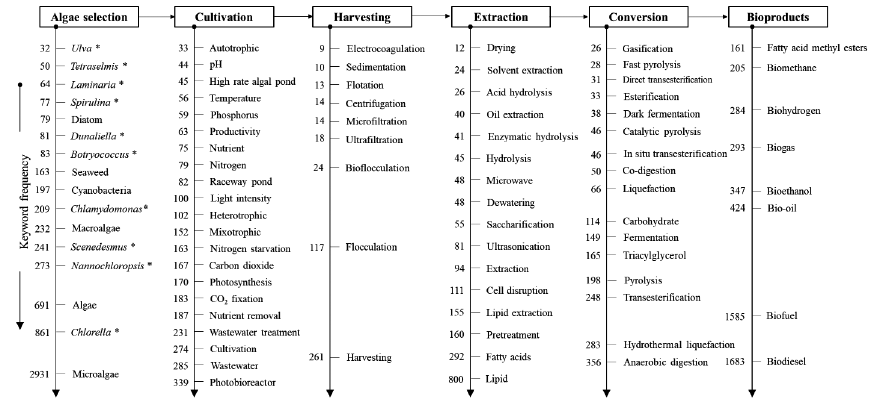
Figure 8. Flow chart of algae biorefinery combined with keyword frequency